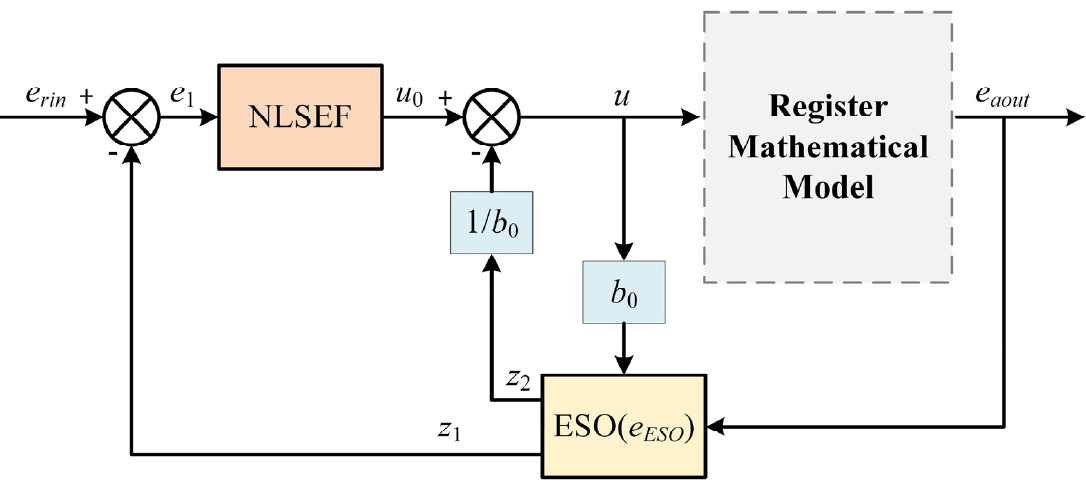
6 of 18 Figure 3. The structure of the feedforward controller. According to the invariance principle, the speed-coupled and tension-coupled disturbances need to be eliminated, which means each disturbance is set to 0. Then, the expression for the feedforward controller of the flexographic machine register system designed for disturbances is: s